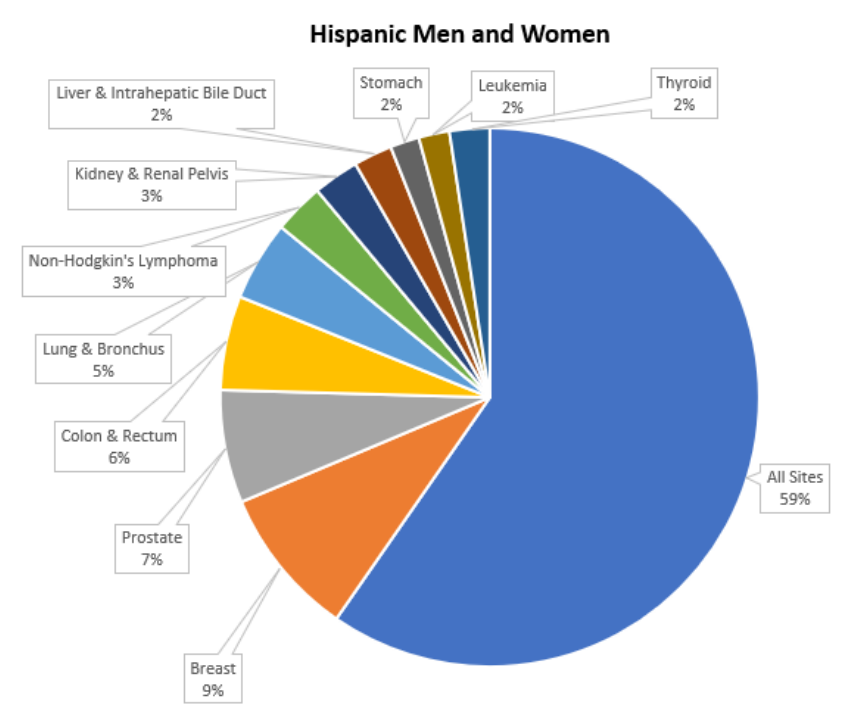
Figure 2. Top 10 cancer sites for the Hispanic group (2014–2018). ( A ) Cancer incidence rates per 100,000 in women. ( B ) Cancer incidence rates per 100,000 in men. ( C ) Cancer incidence rates per 100,000 in men and women.